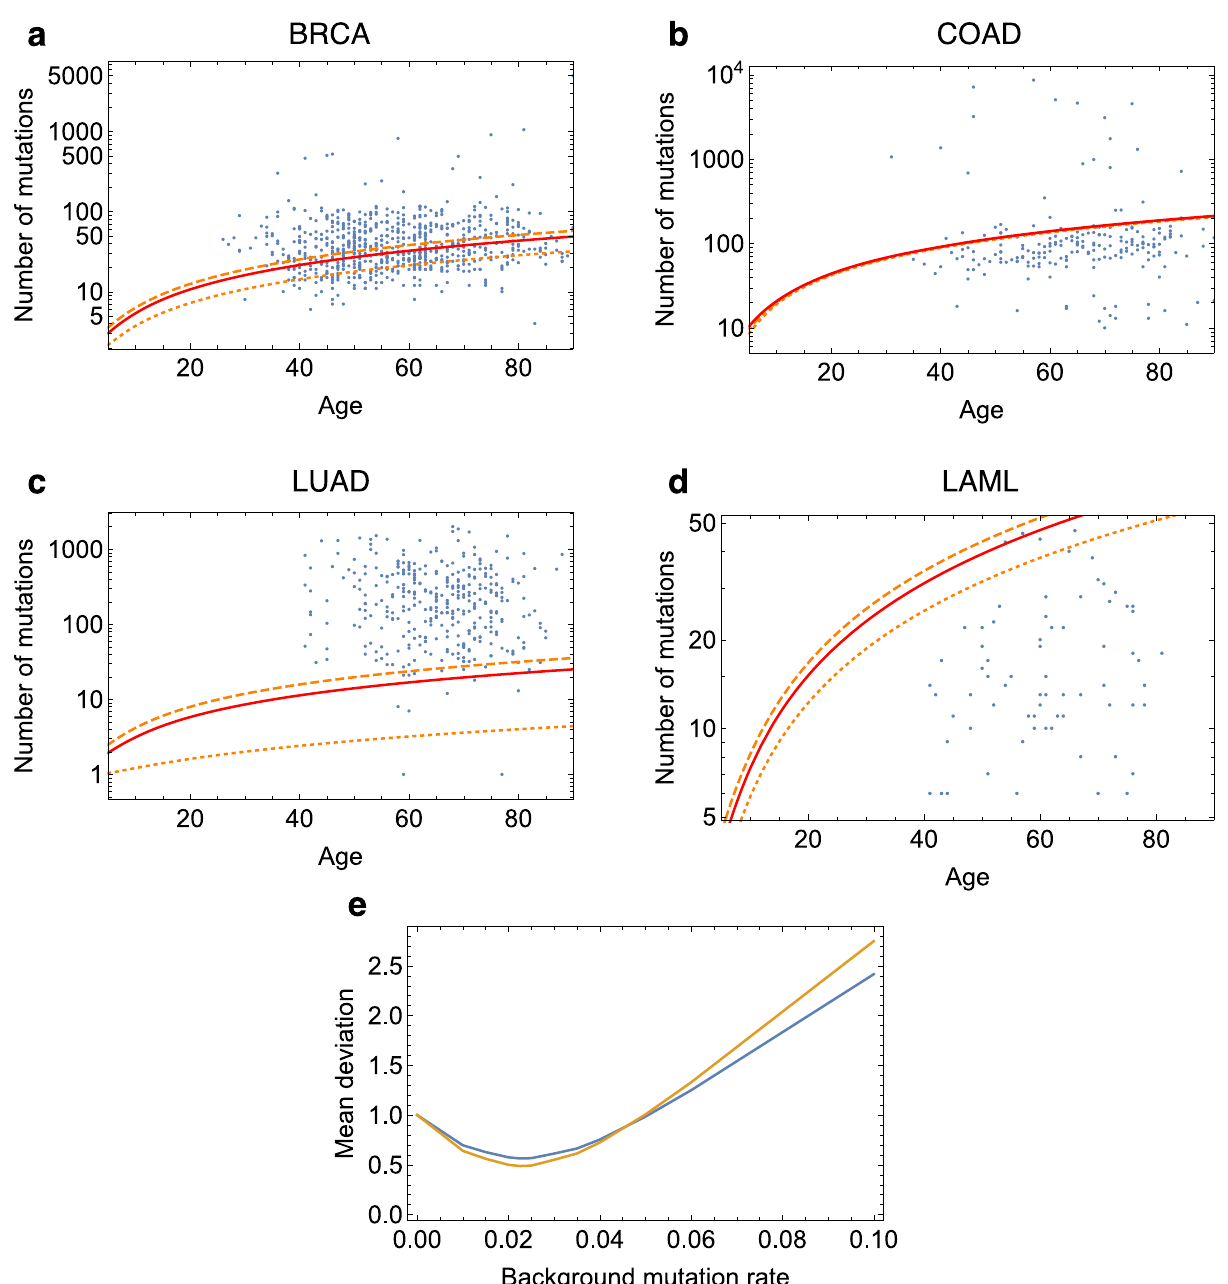
Fig. 2 | Predicted and observed number of mutations. a – d Predicted and observed number of mutations as a function of age. Observed number of somatic mutationsfoundincancers(bluedots)ofpatientsofdifferentagesfromtheTCGA database, compared with the expected number of mutations solely due to the endogenous mutational processes in patients of the same age, predicted by our model(2),for four typesof cancer:breast (BRCA), colon (COAD),lung (LUAD) and leukemia(LAML)(seeSupplementaryFig.S3forothercancertypes).Theexpected numberofmutations(2)isgivenforanumberofdriversequal n =2(dottedorange